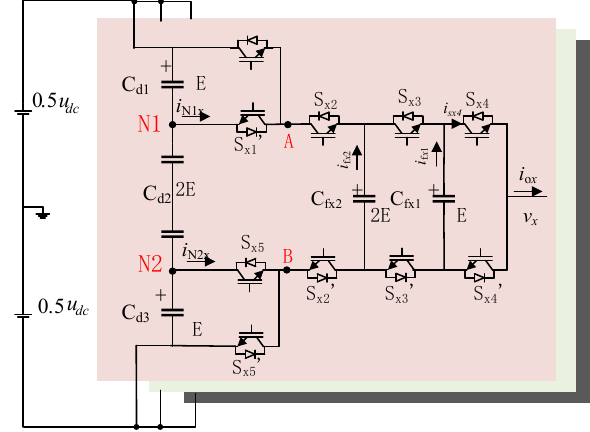
Figure 6. The circuit of the 5L-HC (showing only one phase) [25]. A simulation is conducted to investigate the influence caused by the absolute operation in (4). The waveforms of s ga1 , s ga2 , (s ga1 –s ga2 ), and |s ga1 –s ga2 | under C r = 6 are shown in Figure 7, and the Fourier transformation is conducted to show their spectrum.